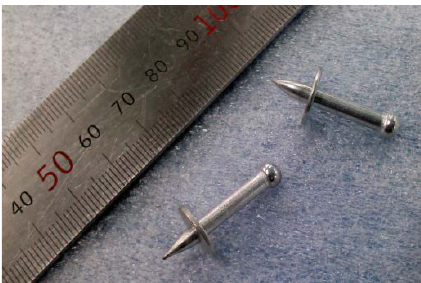
Figure 4. Fastener for added combination of reinforced concrete (RC) beam and AGC